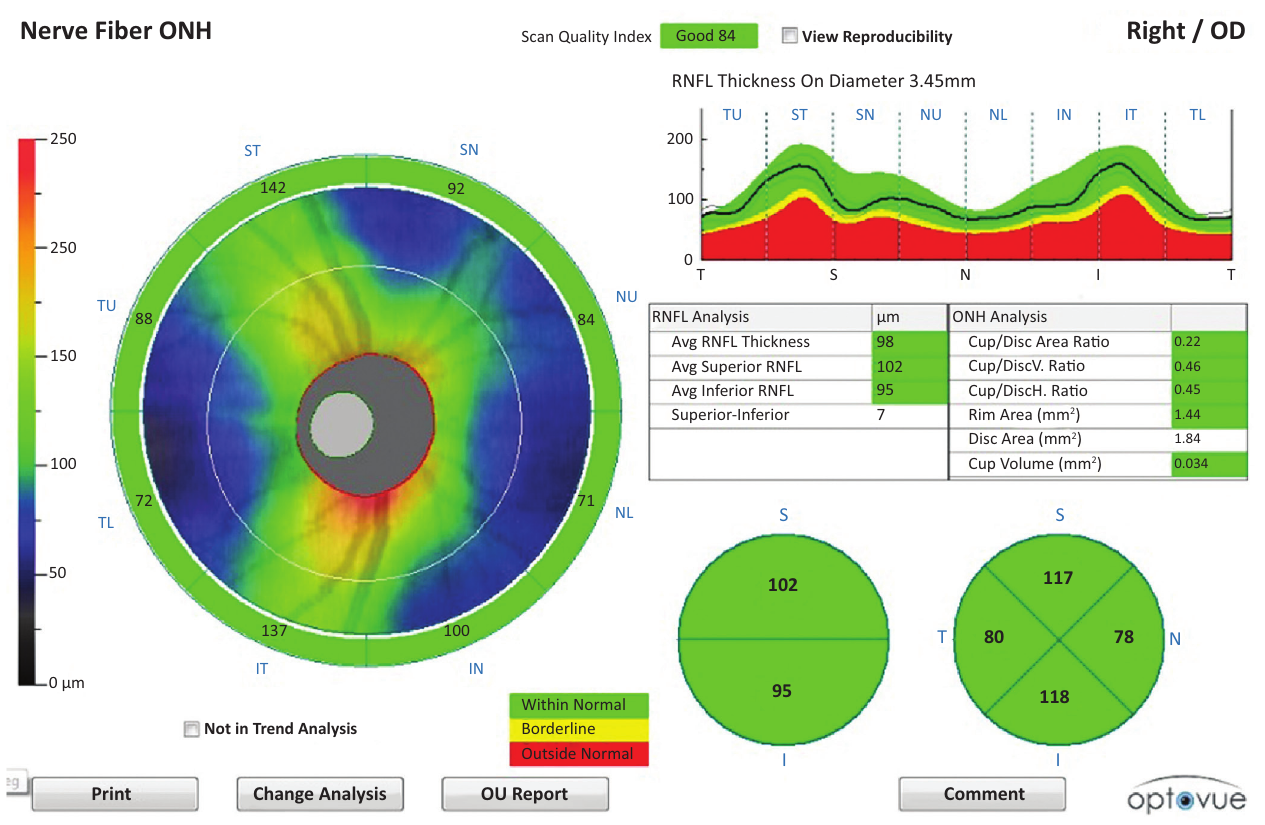
FIGURE 1: A retinal nerve fibre layer map showing the average global and quadrant retinal nerve fibre layer